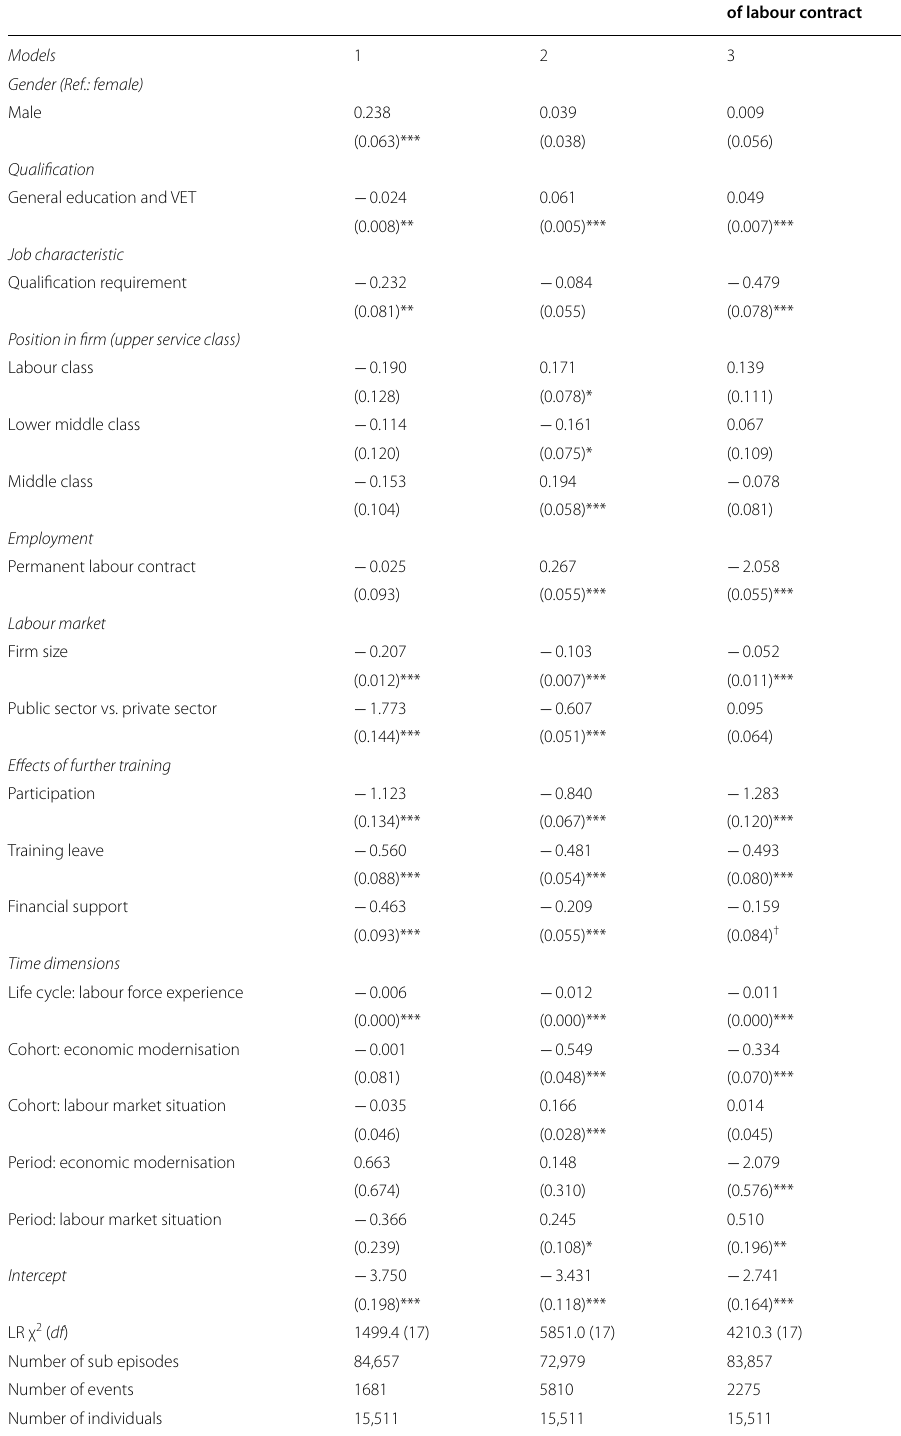
Table 3 Effects of further training on the stability of employees’ career (exponential